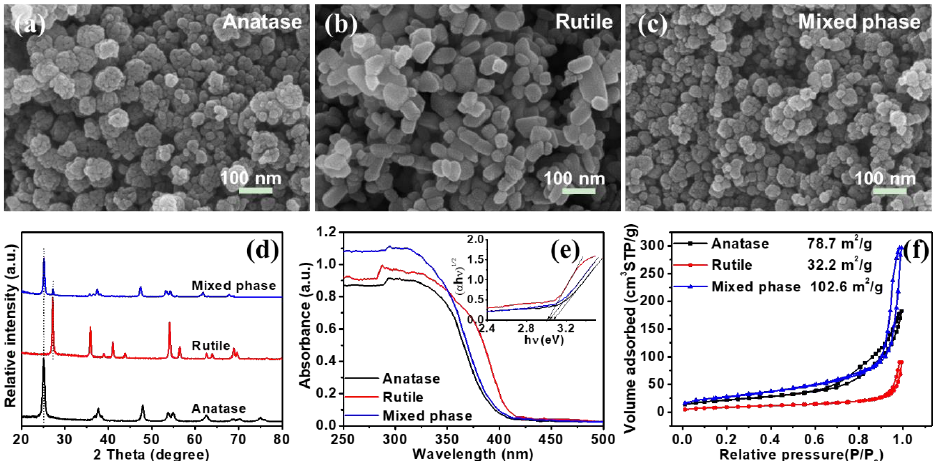
Figure 1. The SEM images ( a – c ), XRD patterns ( d ), UV–VIS DRS ( e ), Tauc plots (Inset) and N 2 adsorption-desorption isotherms ( f ) of anatase, rutile, and mixed phase.